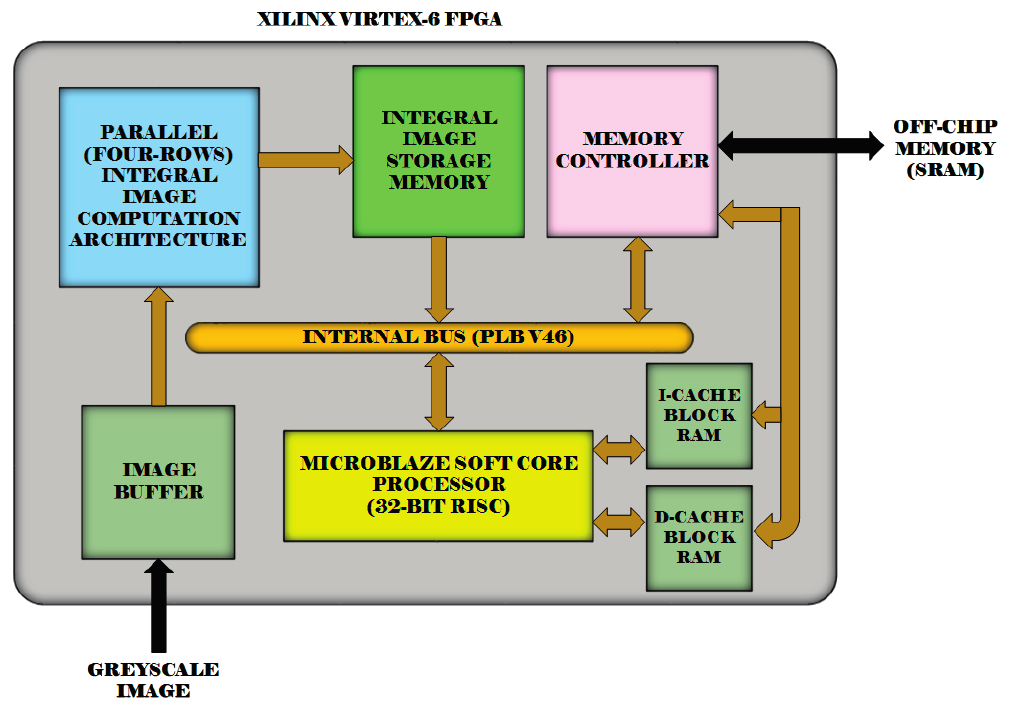
Figure 16. A block diagram of the implemented fast adaptive binarization system [32] on a Xilinx Virtex-6